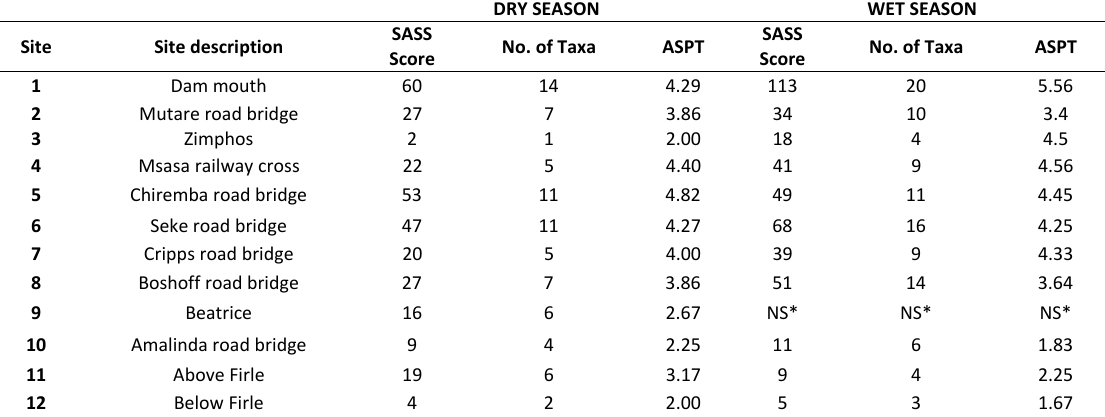
*NS‐No sample, was inaccessible due to weather